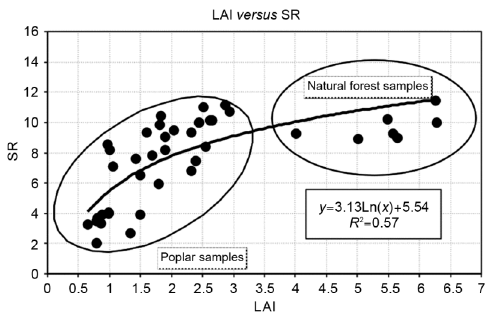
Fig. 3. Logarithmic regressive relationship between LAI and SR. Leaf area index values appear to be dis- tributed in two different populations. The mature nat- ural forest express the highest values of